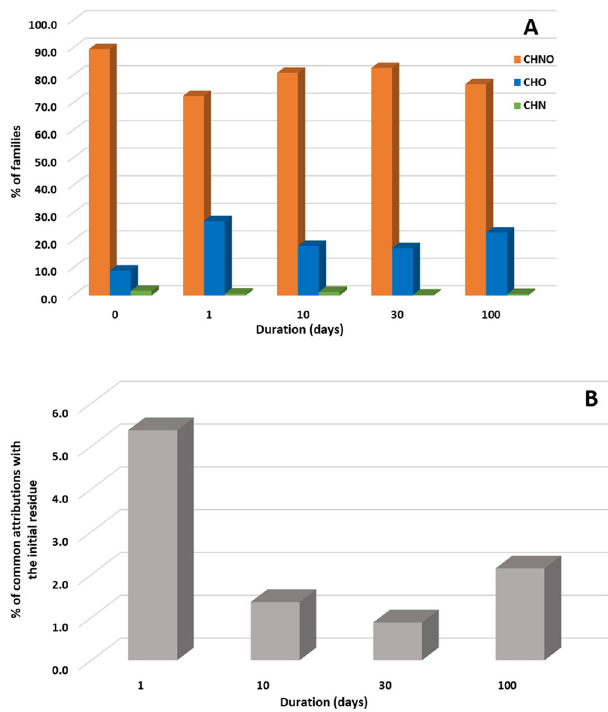
Fig. 3 Evolution of chemical families and common attributions with the pre-accretional residue. Percentages of CHNO, CHO, and CHN families ( A ) and of common molecular attributions with the pre-accretional organic analog ( B ) for the different experimental times in the post-aqueous organic products. Common molecular attributions correspond to molecular attributions that are common between the pre-accretional residue and the residue after 1, 10, 30, or 100 days of